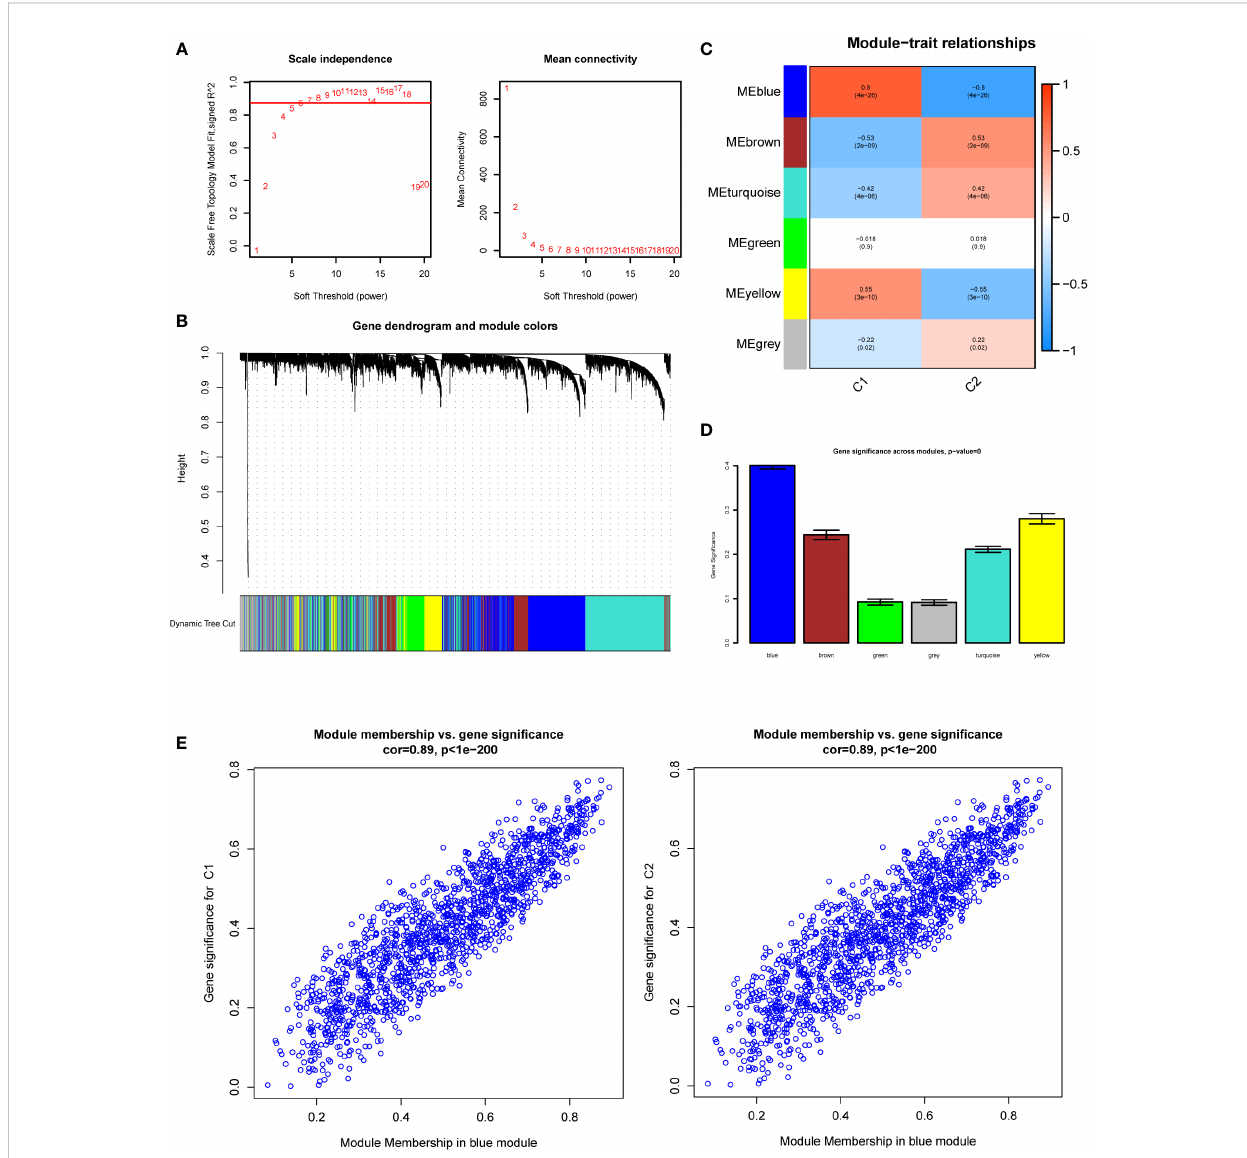
FIGURE 3 Weighted Gene Co-Expression Network Analysis (WGCNA). (A) Scale-free fi t index and network connectivity under different soft thresholds. (B) The gene hierarchical clustering dendrogram. The modules corresponding to the branches are marked with color represented by the color band under the tree. (C) Heatmap of the correlation between gene modules and DKD subtypes. (D) Absolute value comparison of the correlation between genes within each module and DKD subtypes. (E) Scatter plot of module eigengenes in blue